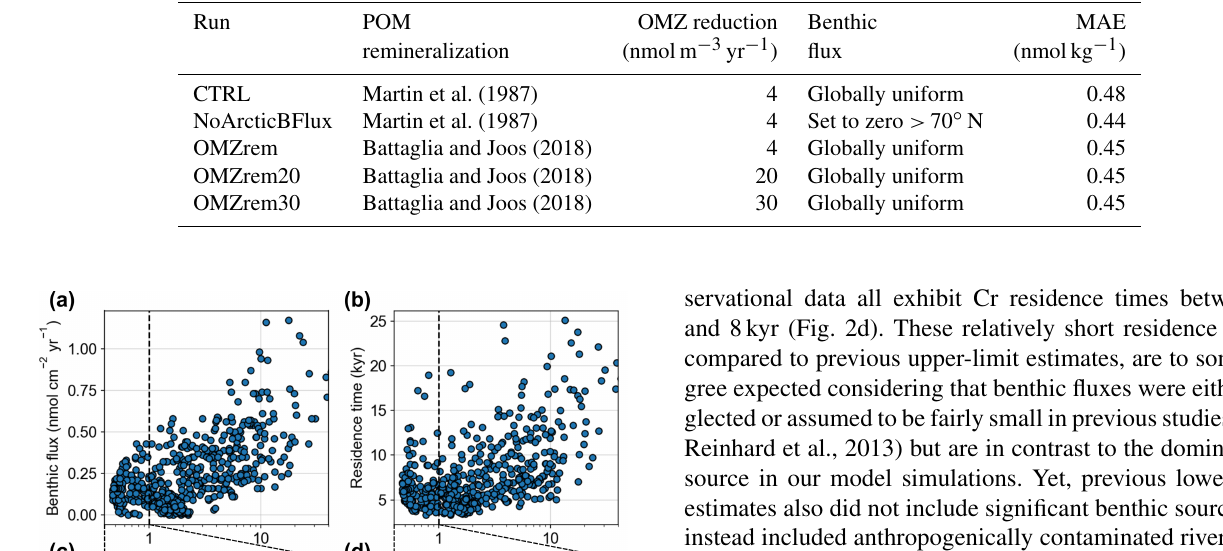
Table 2. Different model simulations. Parameters not listed here were kept as in the control run (see Table 1). The mean absolute error (MAE) was determined by comparing seawater observations to the model output at the closest grid cell.